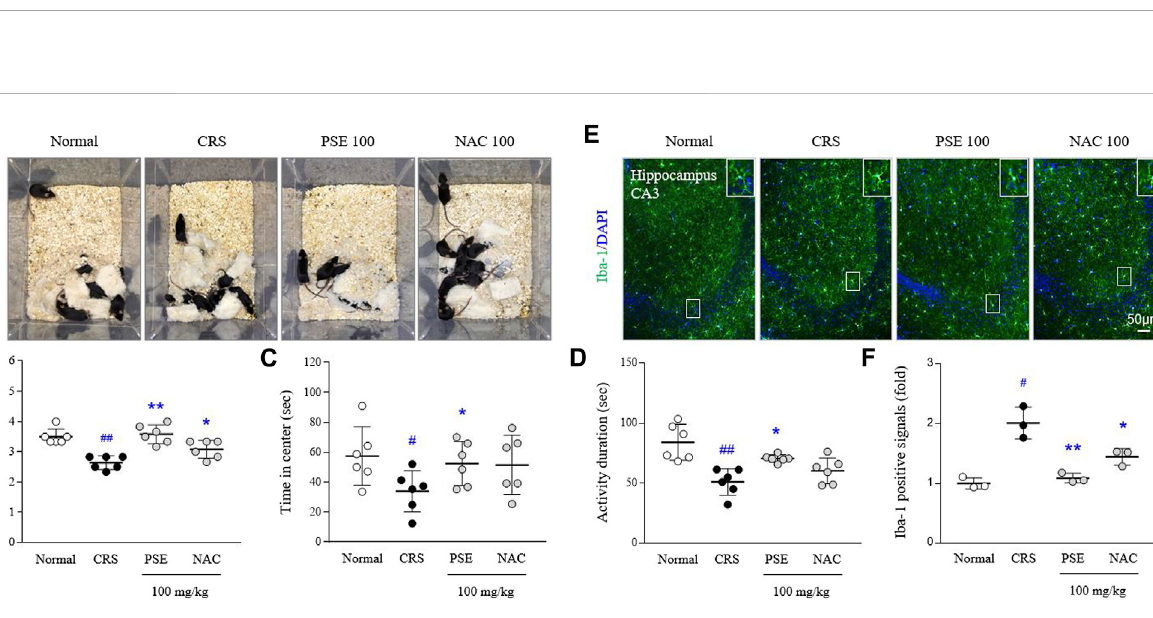
FIGURE 5 Sickness-, anxiety- and depressive-like behaviors, and microglial over-activity. Representative images of cotton nest construction (A) and nest score in the nest building test (B) , latency time in the center zone in the open fi eld test (C) , and activity duration in the forced swimming test (D) . Immuno fl uorescence signals of Iba-1 in the hippocampus were measured (E) , and its intensities were semiquantifed (F) . The data are expressed as the mean ± SD. # p < 0.05 and ## p < 0.01 compared with the normal group; * p < 0.05 and ** p < 0.01 compared with the CRS-induced